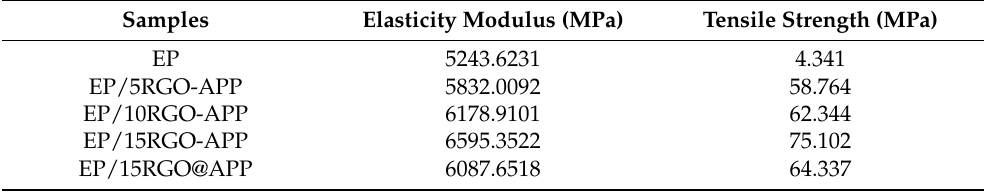
Table 4. Tensile strength and elastic modulus of pure EP and flame-retardant